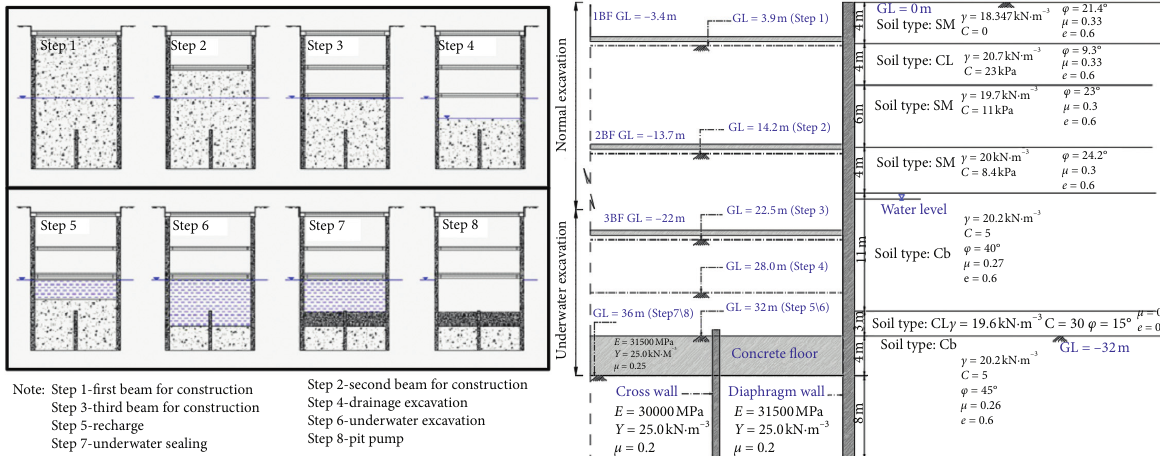
Figure 3: Excavation geometry and stratigraphy for YDM project.